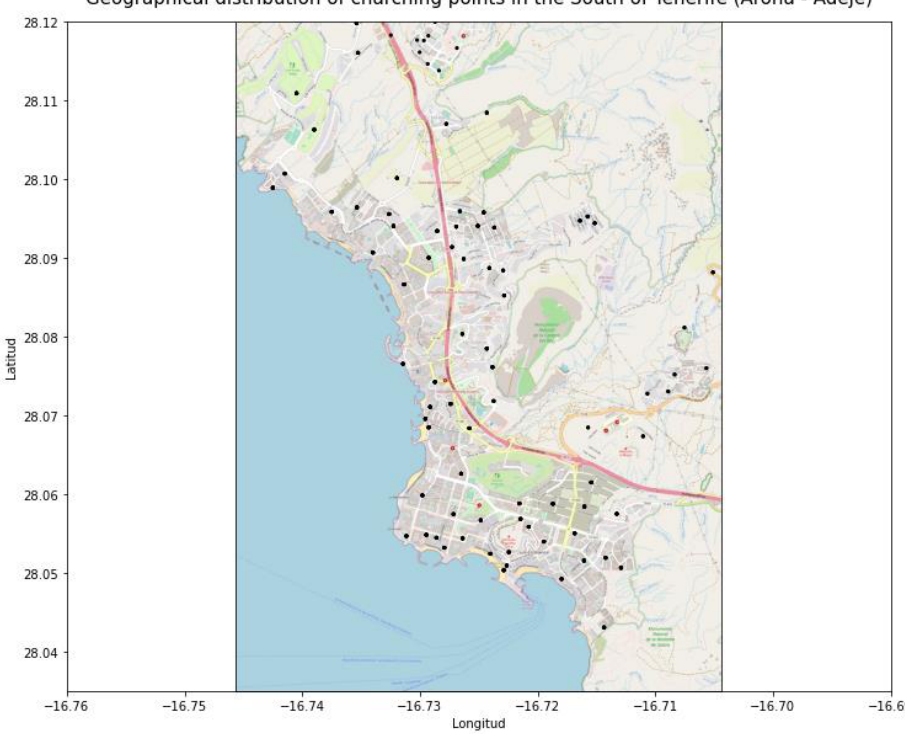
Figure 20. Distribution of charging points in the touristic areas of the South of Tenerife (Arona—Adeje) with each black dot representing a charging point.